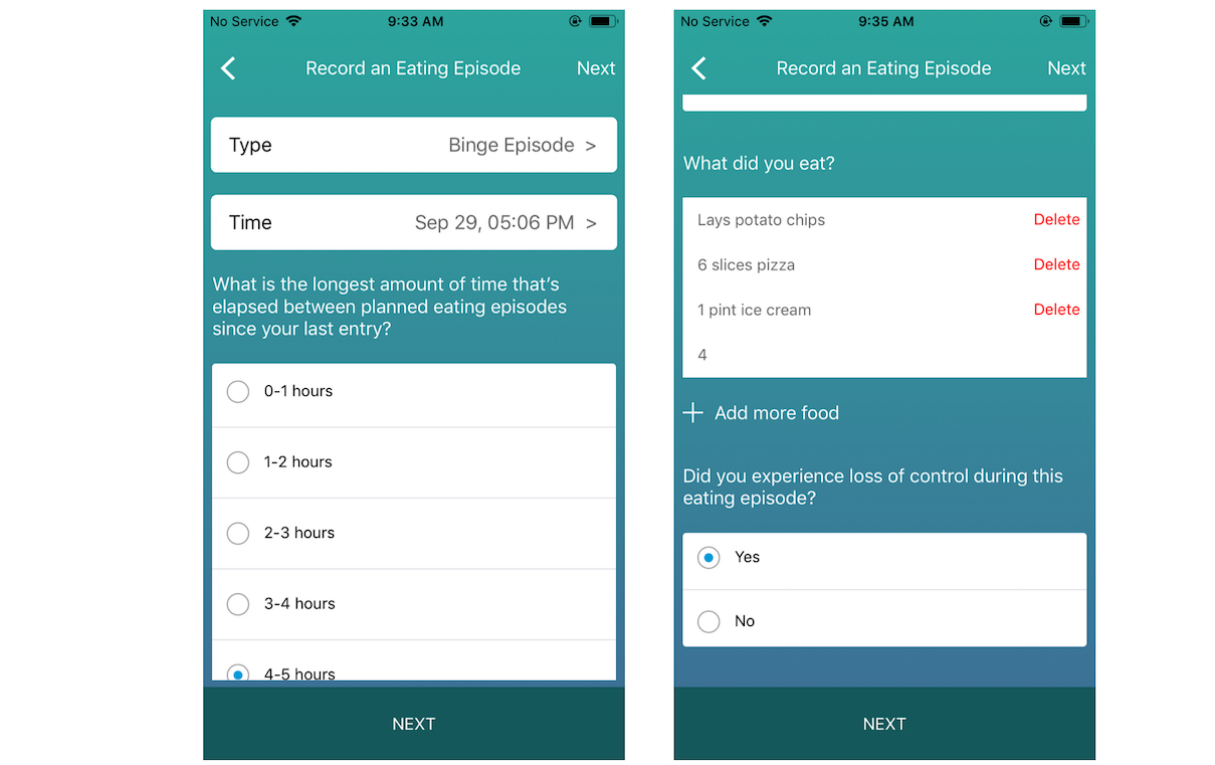
Figure 2. Screenshots of the electronic self-monitoring form of the CBT+ smartphone